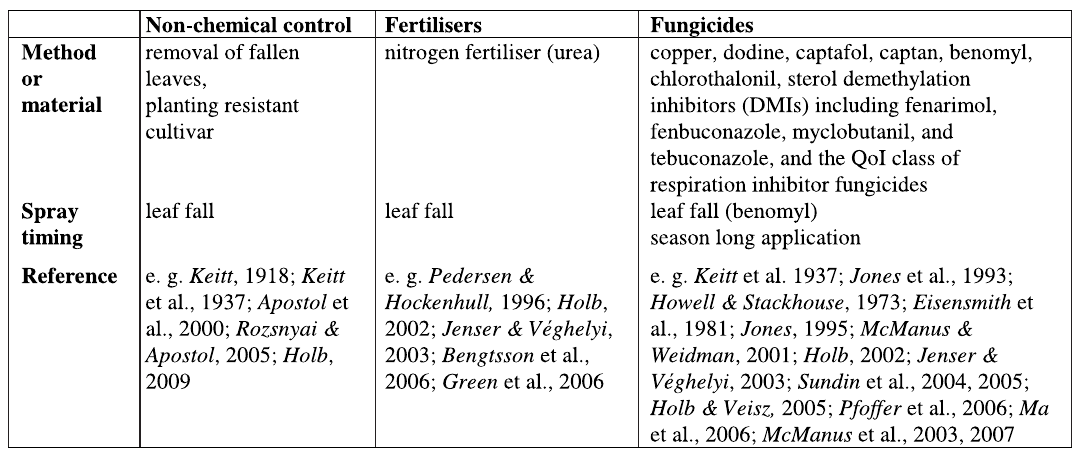
Table 1. Some features of disease management of cherry leaf spot in cherry orchards with non-chemical control approach, fertilisers and